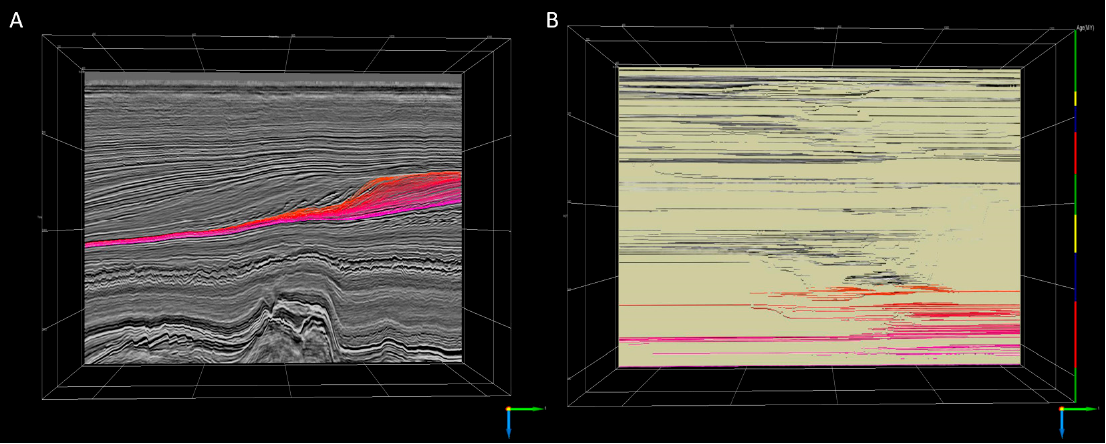
Figure 8. Synchronized seismic sequence stratigraphic interpretation done in two domains; ( A ) the Structural or Chronostratigraphic domain and ( B ) the Wheeler domain.